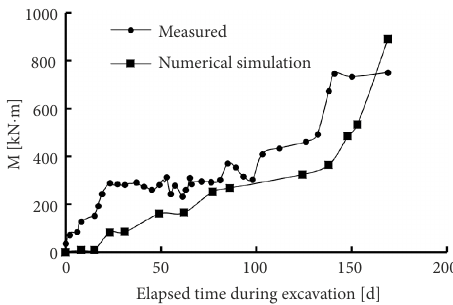
Figure 13. Comparison of the bending moments at monitoring points (8)–(H)